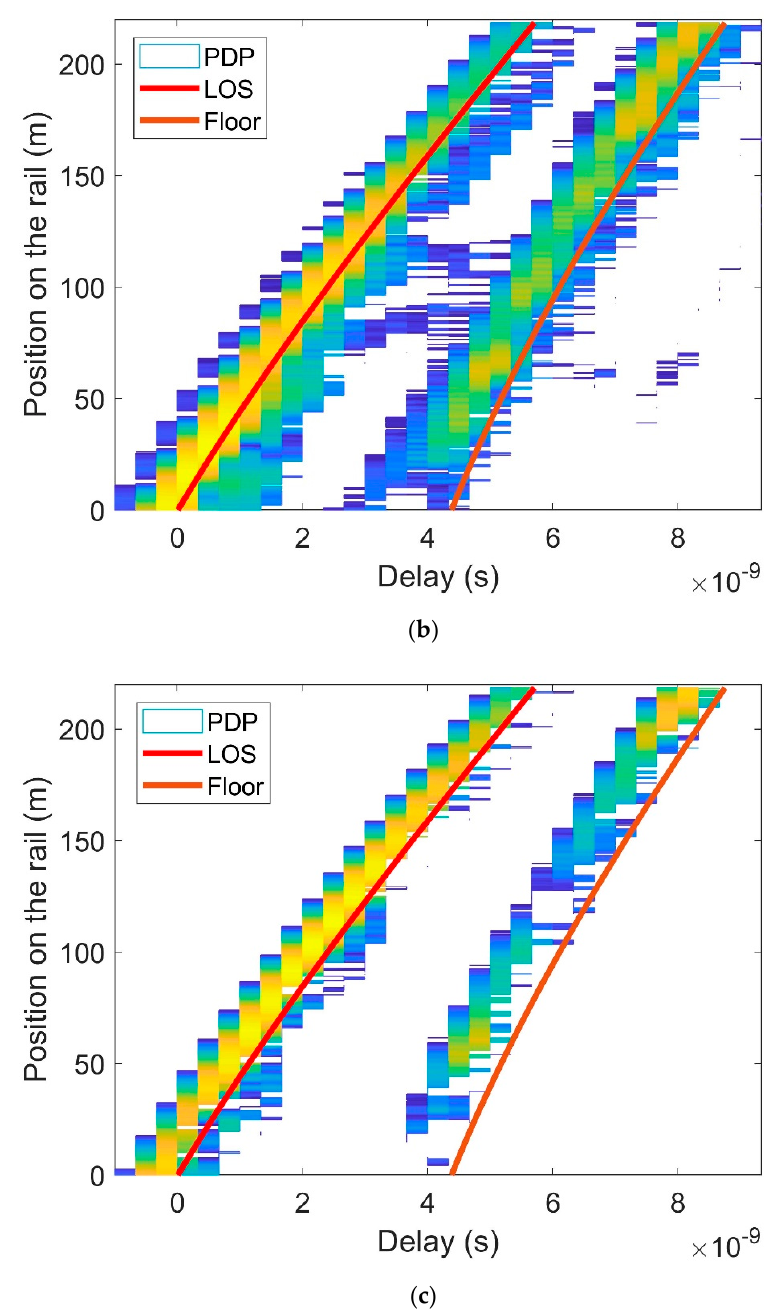
Figure 9. PDP at auditorium, at 60.5 GHz: ( a ) Received by antenna “2”; ( b ) by antenna “3”; ( c ) by antenna “4”.